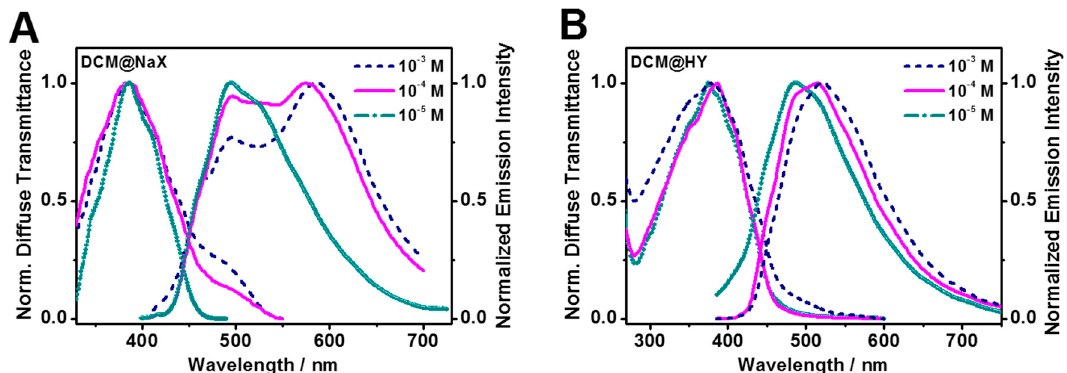
Figure 2. Normalized UV–visible diffuse transmittance and fluorescence spectra of DCM interacting with ( A ) NaX and ( B ) HY zeolites in dichloromethane suspensions at different initial dye concentrations: 1 × 10 − 3 (dashed line), 1 × 10 − 4 (solid line), and 1 × 10 − 5 (scattered-solid line) M.